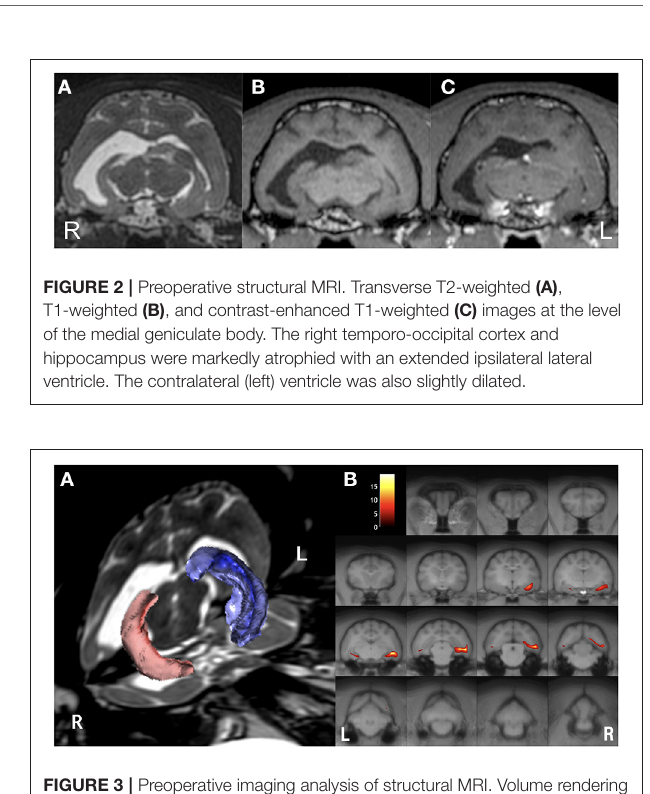
FIGURE 3 | Preoperative imaging analysis of structural MRI. Volume rendering for hippocampal volumetry (A) and the result of statistical voxel-based morphometry analysis for gray matter (B) . The volume of the right (red) hippocampus was 0.12 cm 3 , whereas the left (blue) was 0.24 cm 3 (A) . On the map of voxel-based morphometry analysis (B) , the colored regions indicate significantly different areas compared with 12 healthy controls. Note, the left (L)/right (R) direction of voxel-based morphometry was different from the conventional direction.